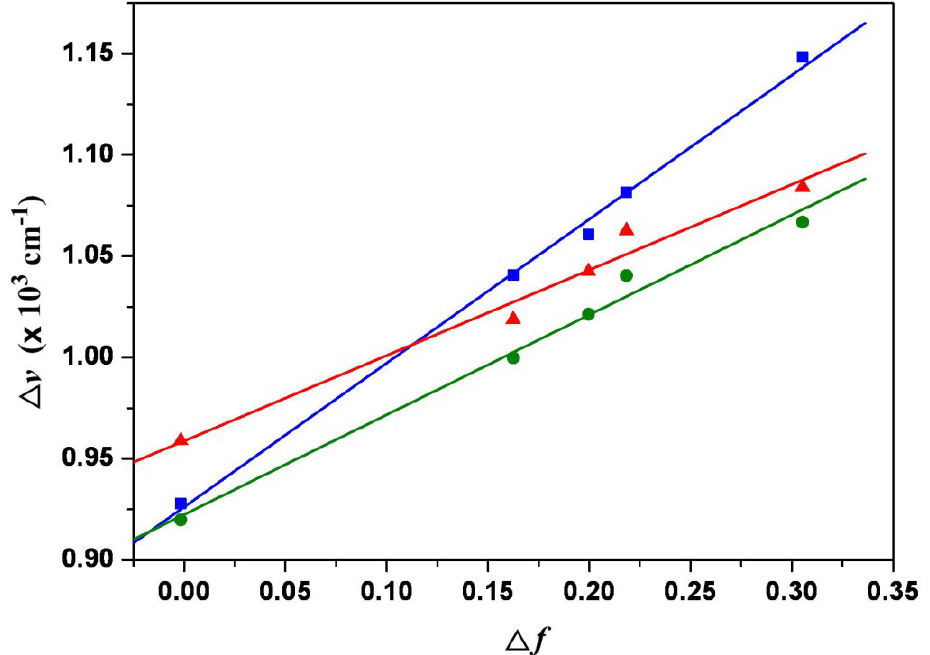
The plot of the Stokes shift   f  is sufficiently linear for 1a – 1c (Figure 5). fa values can be estimated as 7.9 D, 9.1 D and 9.7 D for 1a – 1c . These values indicate that the 1,7-dialkyamino-substituted PBIs ( 1a – 1c ) have larger dipole moment changes than that (7.4 D) of the 1,7-diamino-substituted compound ( 2 ). Figure 5. Lippert–Mataga plots for 1a (blue line), 1b (green line), and 1c (red line). The solvents from left to right are (1) cyclohexane; (2) diethyl ether; (3) ethyl acetate; (4) dichloromethane, (5)